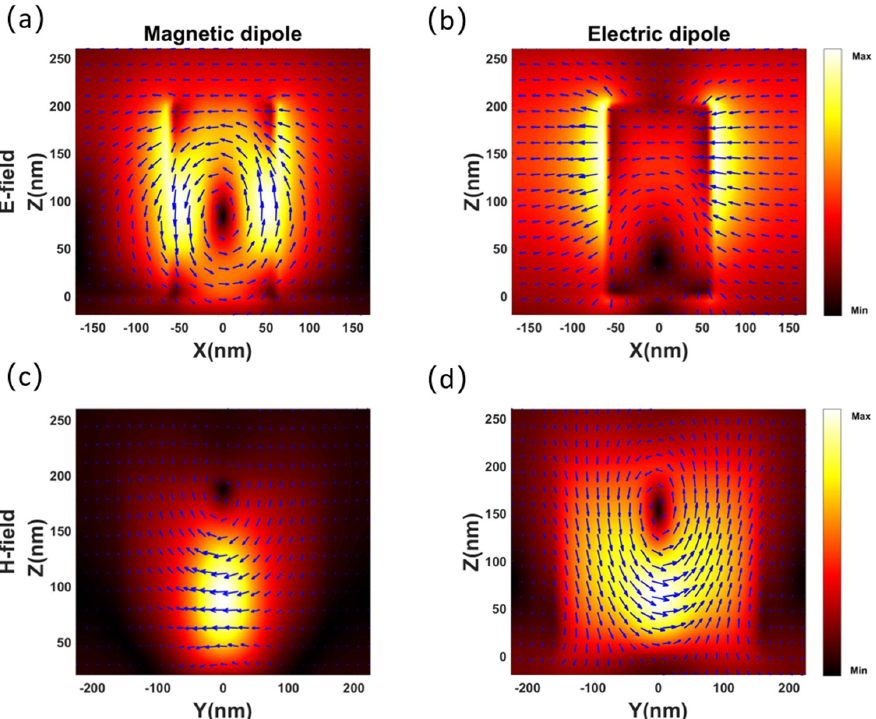
Figure 5. Simulated electric field magnitude distributions | E | 2 and vector distributions of the ( a ) MD and ( b ) ED resonances in the x-z plane. Simulated magnetic field magnitude distributions | H | 2 and vector distributions of the ( c ) MD and ( d ) ED resonances in the y-z plane.